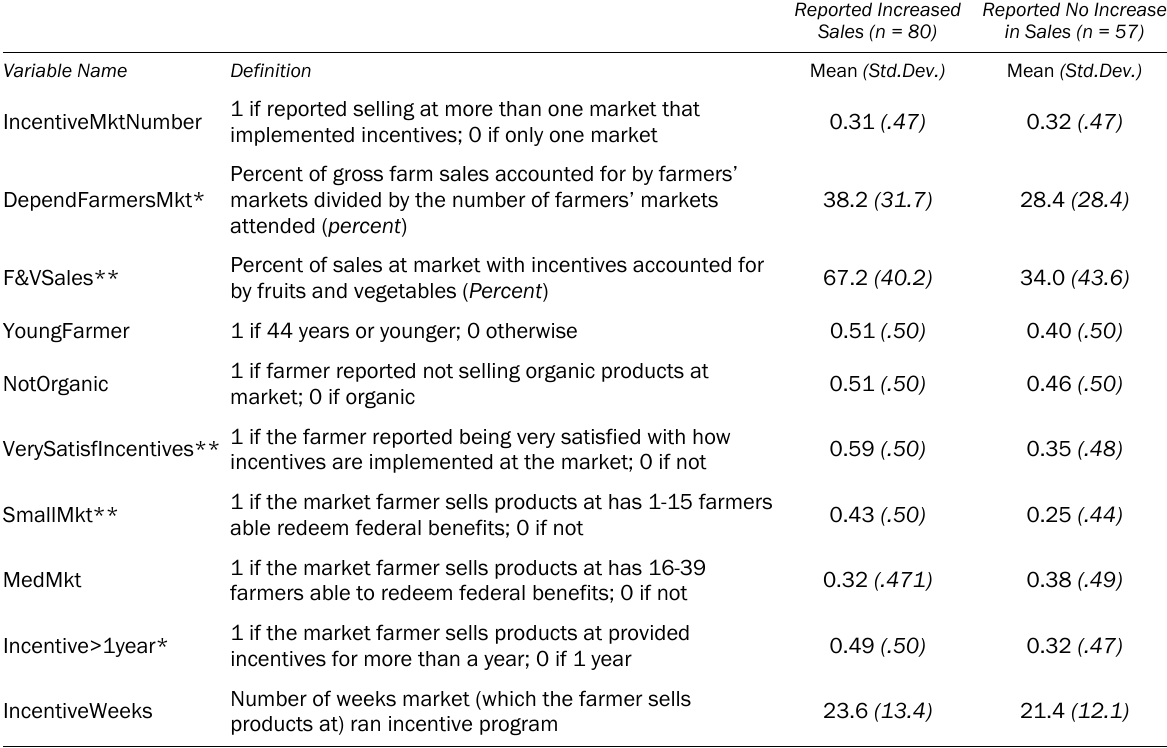
Table 4. Summary Statistics of Variables Used in the Logistic